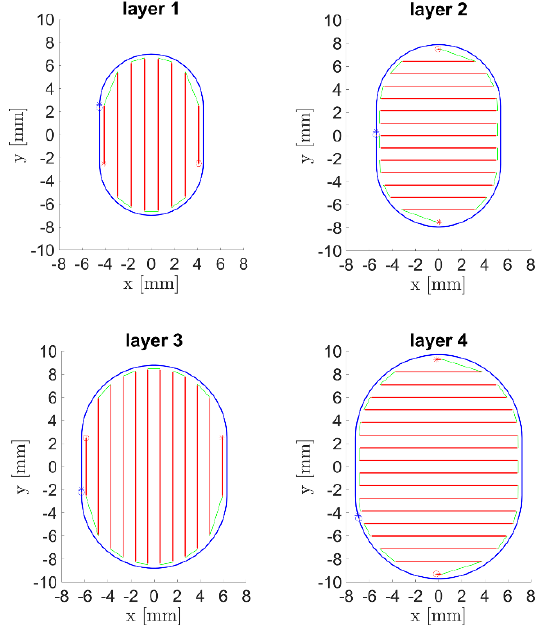
Figure 6. Laser tool path for the DMD groove fillings, with raster tracks in red, linking moves in green, and outer contour tracks in blue.